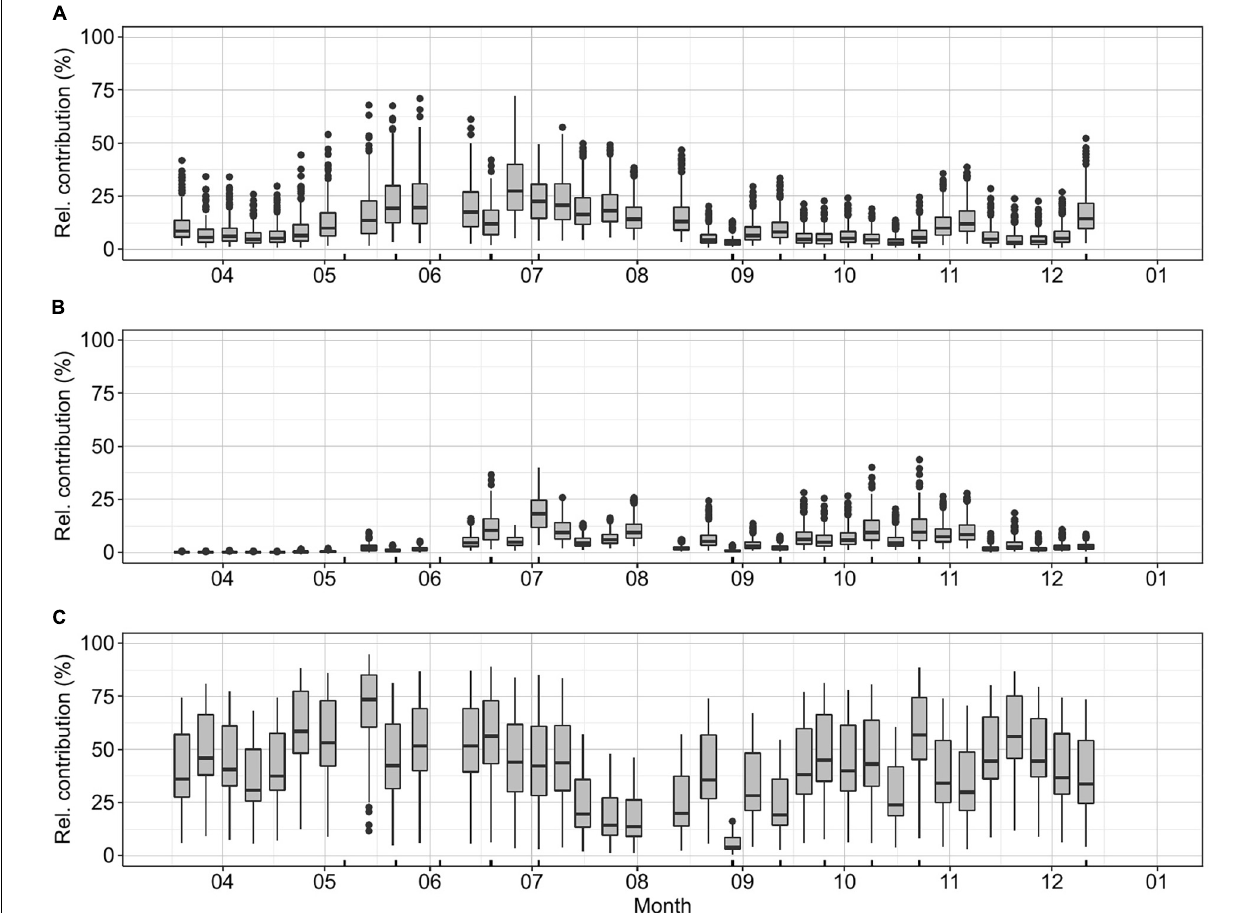
FIGURE 3 | K-station weekly relative carbon biomass contribution to the total phytoplankton community for (A) PE-rich, (B) PC-rich, and (C) PPE. The relative contribution of picophytoplankton based on the carbon biomass concentration was estimated for each value included in Supplementary Table 1 . Ticks on the x -axis mark the dates when a bioassay was